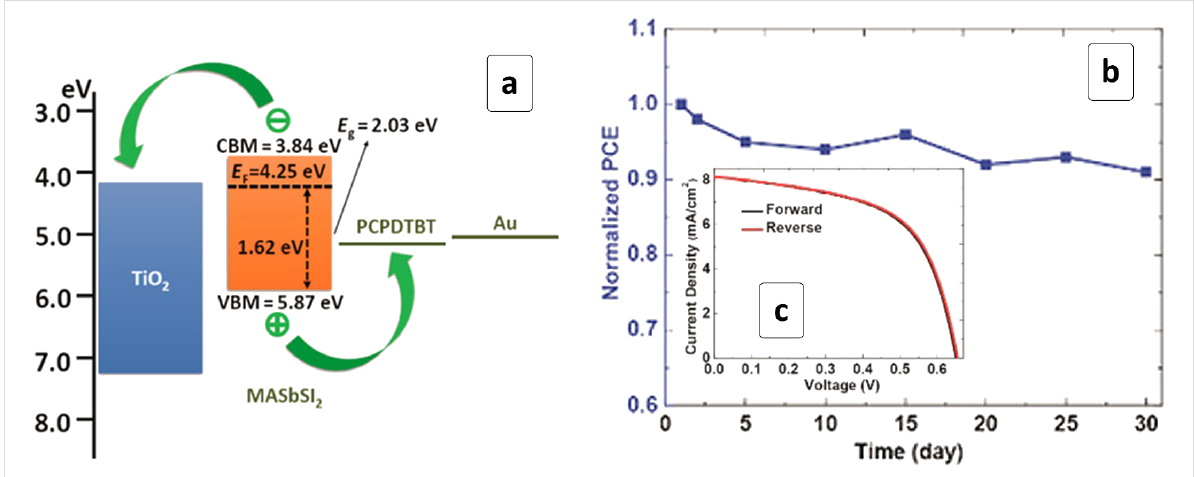
Figure 14: Energy diagram (a), normalized IPCE tested for a period of 30 days (b) as well as current–voltage characteristics registered at forward and reverse bias (c) of a solar cell based on MASbSI 2 HP. The PCPSTBT abbreviation is explained in the notes of Table 1. Reprinted and adapted with permission from [87], copyright 2018 American Chemical